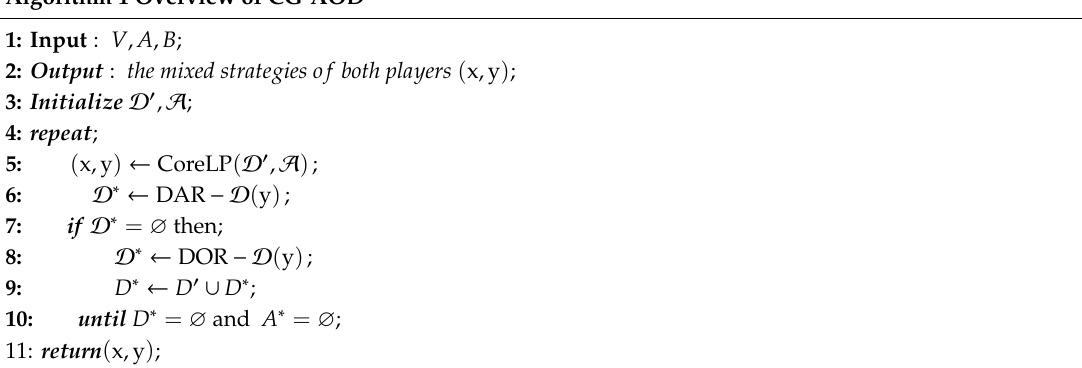
Algorithm 1 Overview of